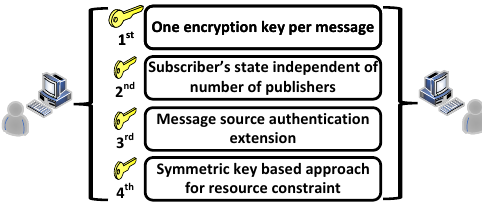
Figure 5. General structure of